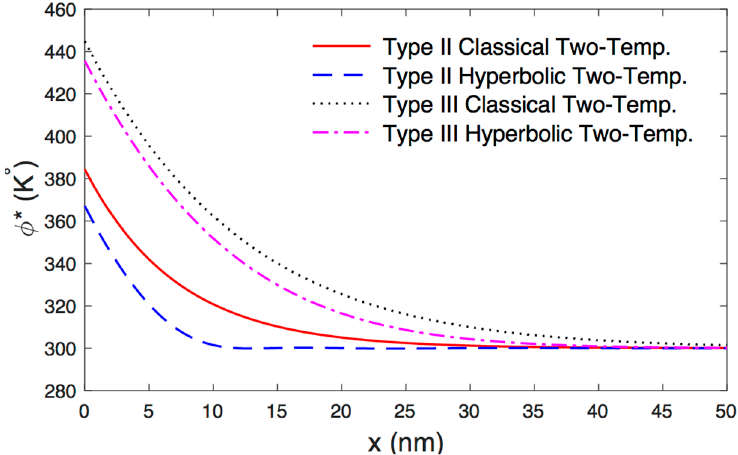
Figure 4. The variation of conductive temperature versus the distance.